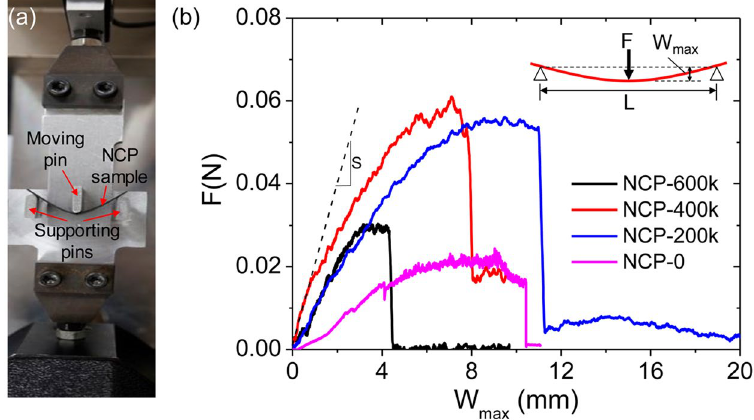
Figure 4. ( a ) Setup of 3-point bending test and ( b ) the obtained force-deflection curves of different NCP samples. The maximum bearable curvature and the flexural modulus of NCPs are deduced from c 2 and E = L 3 S /4 ah 3 respectively, where L is the span between two supporting pins, W c κ = W L 12 / f c max for the deflection of the sample at the middle point when fracture, a and h are the width and thickness of the sample’s cross section respectively, and S is the slope of the initial portion of the force-deflection curve, as indicated for the curve of NCP-400k as an